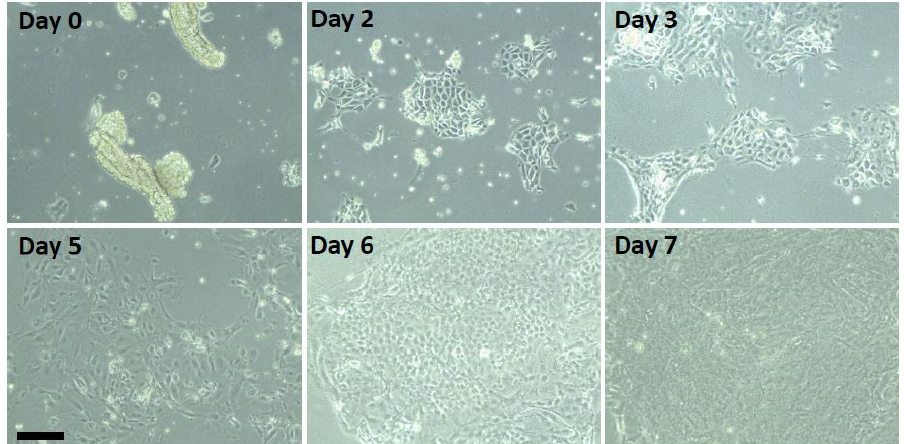
Figure 1. Course of mouse tracheal epithelial cells in culture. Mouse tracheal cells (MTCs) from a single trachea per well were placed on rat-tail collagen coated six-well culture dishes (scale bar represents 50 μ m). On Day 0, the cells can be seen as sheets with beating, motile cilia. The cells take 24–48 h to become adherent, loose their cilia, and start dividing. Initial islands of cells form by day 2, expand over the ensuing 4–5 days, becoming confluent by Day